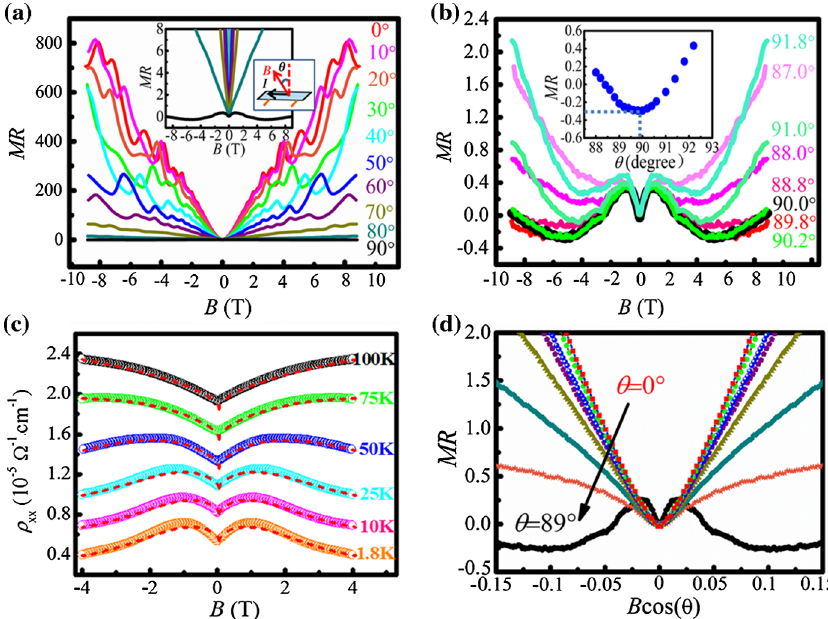
FIG. 2. Angular and field dependence of MR in a TaAs single crystal at 1.8 K. (a) Magnetoresistance with respect to the magnetic field ( B ) at different angles between B and the electric current ( I ) ( θ ¼ 0 ° – 90 °). The inset zooms in on the lower MR part, showing negative MR at θ ¼ 90 ° (longitudinal negative MR), and it depicts the corresponding measurement configurations. (b) Magnetoresistance measured in different rotating angles around θ ¼ 90 ° with the interval of every 0.2 °. The negative MR appeared at a narrow region around θ ¼ 90 °, and most obviously when B==I . Either positive or negative deviations from 90 ° would degenerate and ultimately kill the negative MR in the whole range of the magnetic field. Inset: The minima of MR curves at different angles (88 ° – 92.2 °) in a magnetic field from 1 to 6 T. (c) The negative MR at θ ¼ 90 ° (open circles) and fitting curves (red dashed lines) at various temperatures. T ¼ 1 . 8 , 10, 25, 50, 75, and 100 K. (d) Magnetoresistance in the perpendicular magnetic field component, B × cos θ . The misalignment indicates the 3D nature of the electronic